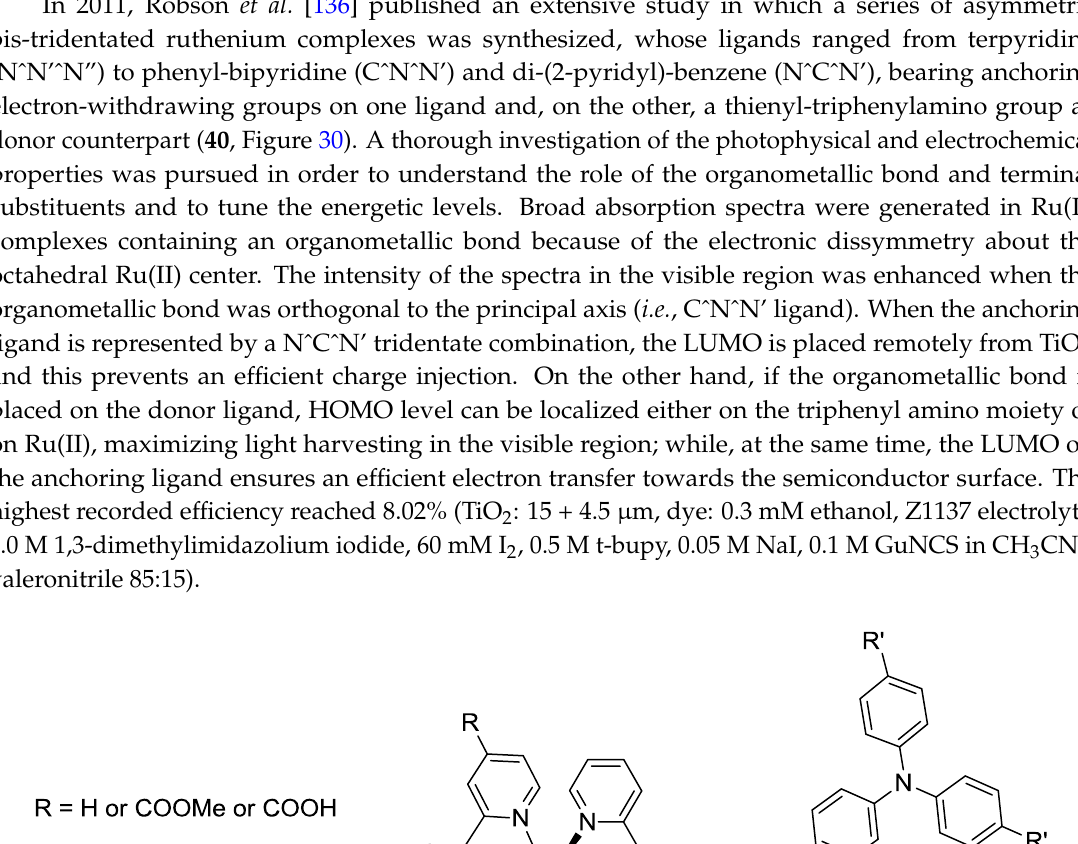
Figure 31. Example of dipyrazinyl-pyridine ligand [135]. Sepehrifard et al. [138,139] investigated a series of homoleptic bis-tridentate ruthenium complexes, employing both tpy and dipyrazinyl-pyridine ligands. The poorer performances of the latter ones were attributed to lower LUMO levels and weaker bonding to TiO 2 . The best results were obtained with terpyridine ligands bearing COOH grafting groups (1.53% efficiency) while the use of dipyrazinyl-pyridine ligands, ester groups or the introduction of a phenylene spacer between the pyridine and the anchoring group all resulted in lower efficiencies. 3.2.8. Triazolate Schulze et al. investigated triazolate as chelating moiety in a series of N^C^N’ cyclometalated ligands [140] and N^N’^N’’ ligands [141]. 1,3-Di(4-triazolyl)benzene and 2,5-di(4-triazolyl)pyridine